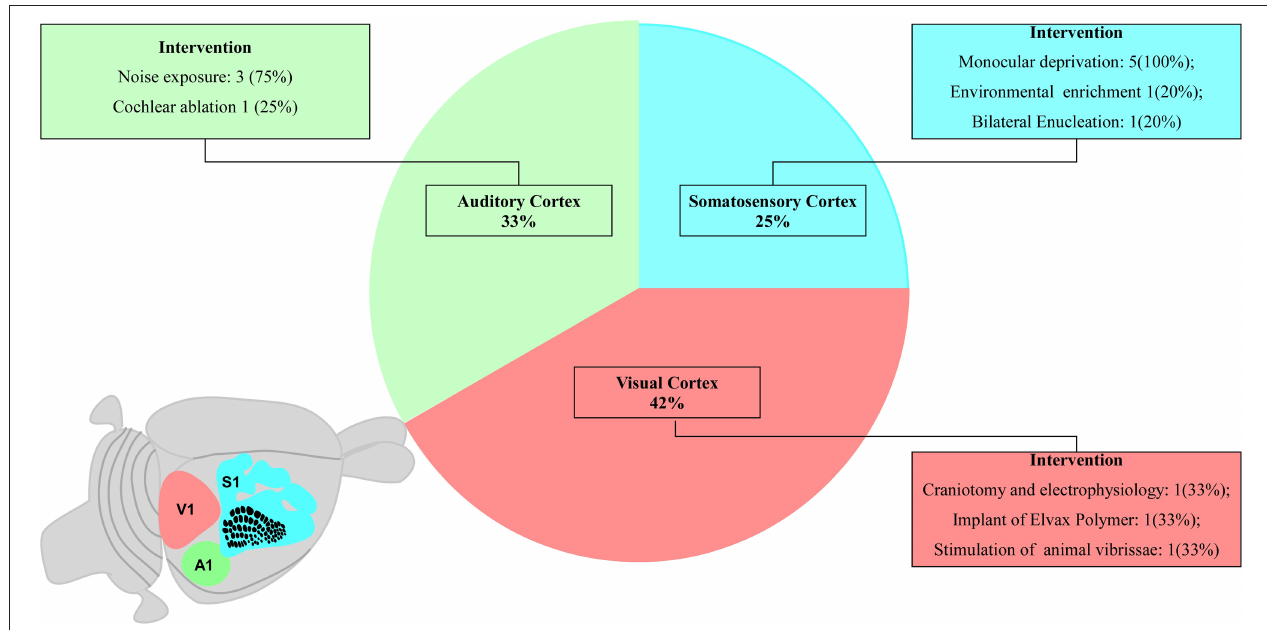
FIGURE 2 | Schematic diagram proportionally shows the number of studies related to each primary sensory area. The schematic diagram of a small rodent brain highlights the primary sensory areas: three studies on the primary somatosensory cortex (S1, blue), four studies on the primary auditory cortex (A1, green), and five studies on the primary visual cortex (V1,